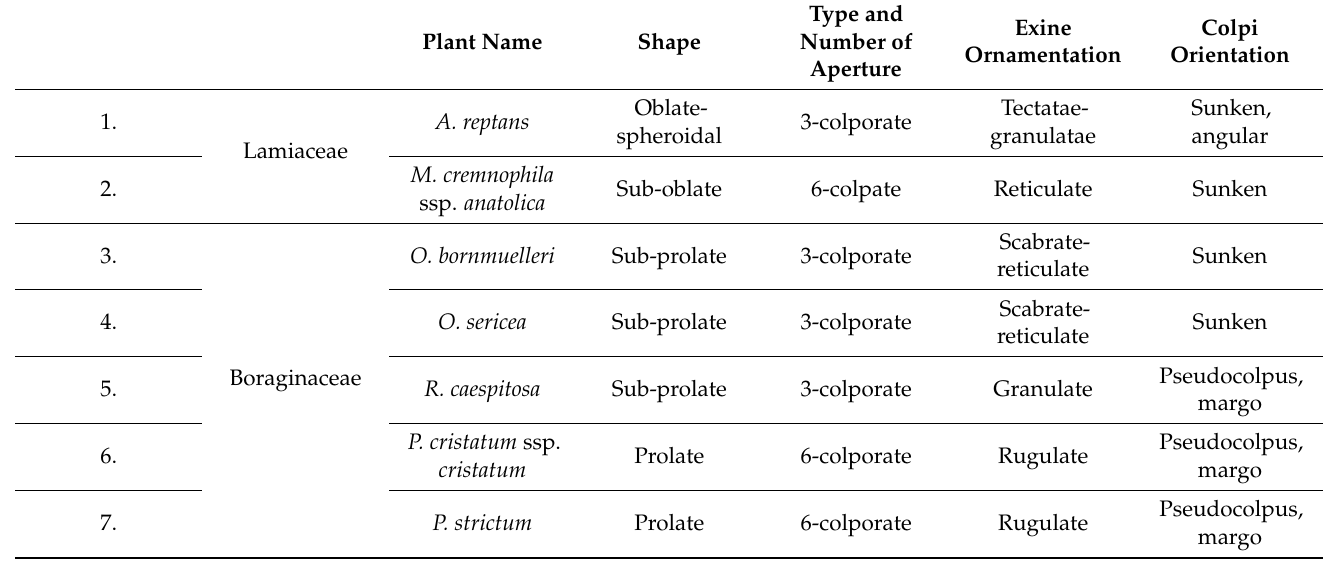
Table 2. Qualitative micromorphological pollen characteristics of selected